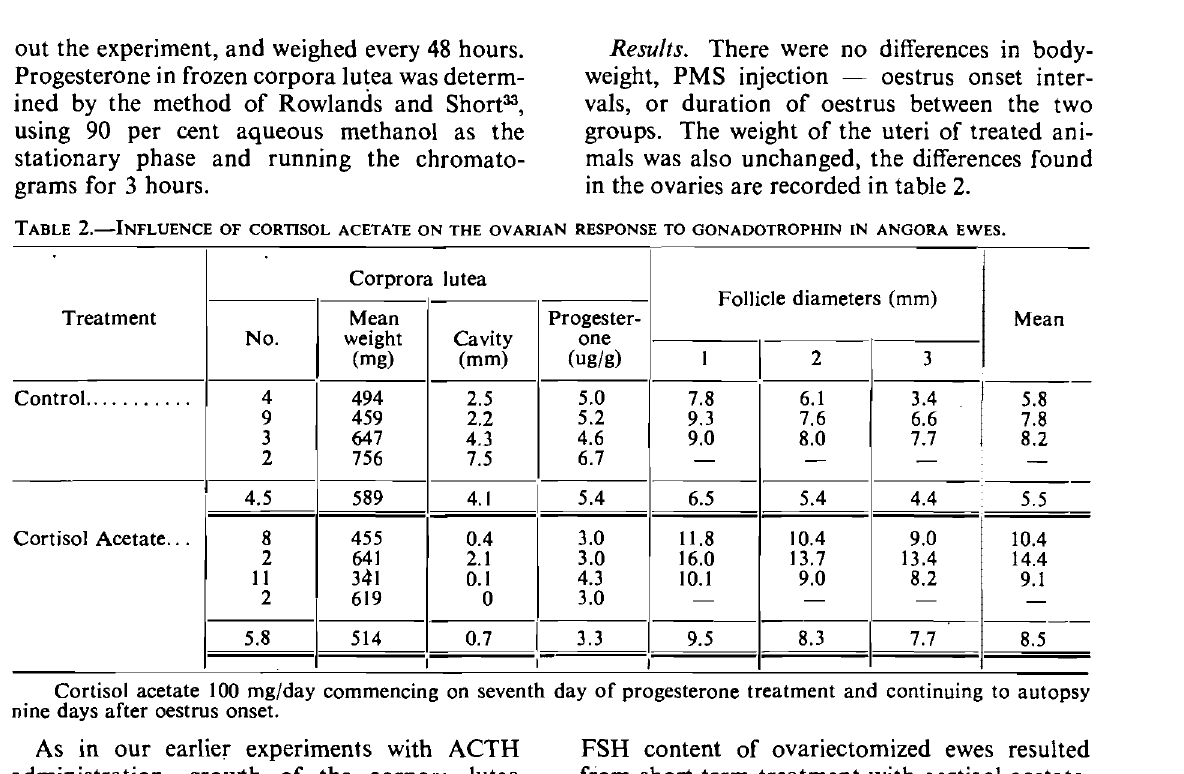
TABLE 2.-INFLUENCE OF CORTISOL ACETATE ON THE OVARIAN RESPONSE TO GONADOTROPHIN IN ANGORA EWES. Corprora lutea Follicle diameters (mm) Treatment Mean Progester- Mean